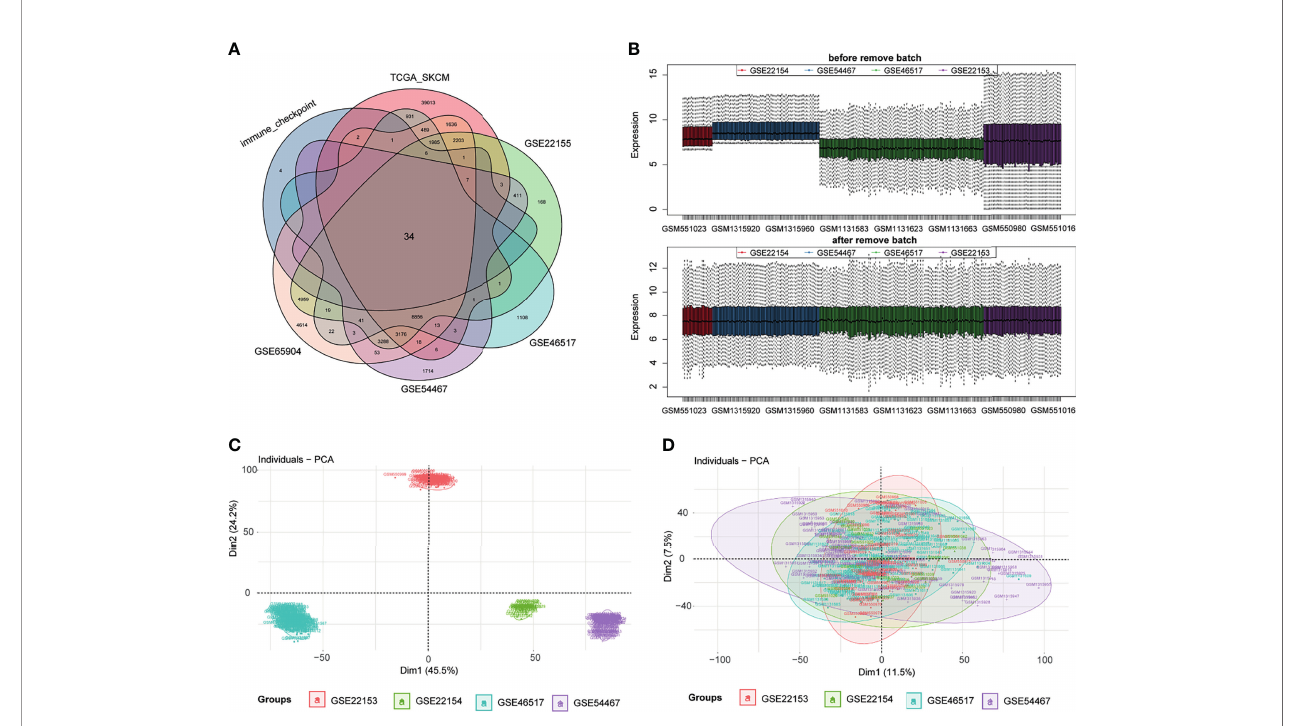
FIGURE 2 | Data processing. Panel (A) shows the common immune checkpoint molecules in six datasets in the form of a Venn diagram. Then, we visualize the results of eliminating the batch effect in the form of a box diagram (B) . The PCA before and after the merger suggests that we have excellently removed the batch effect (C, D)